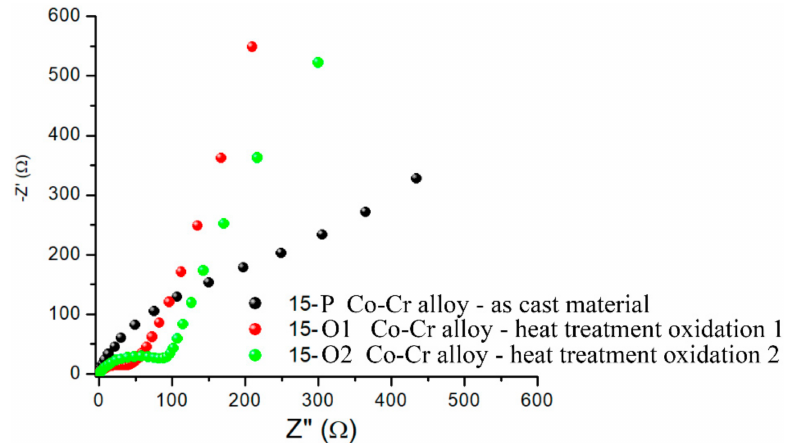
Figure 7. Nyquist representation of EIS for 15-P alloy after casting (black) and after oxidation by heat treatment by Protocol 1 (red) and heat treatment by Protocol 2 (green).